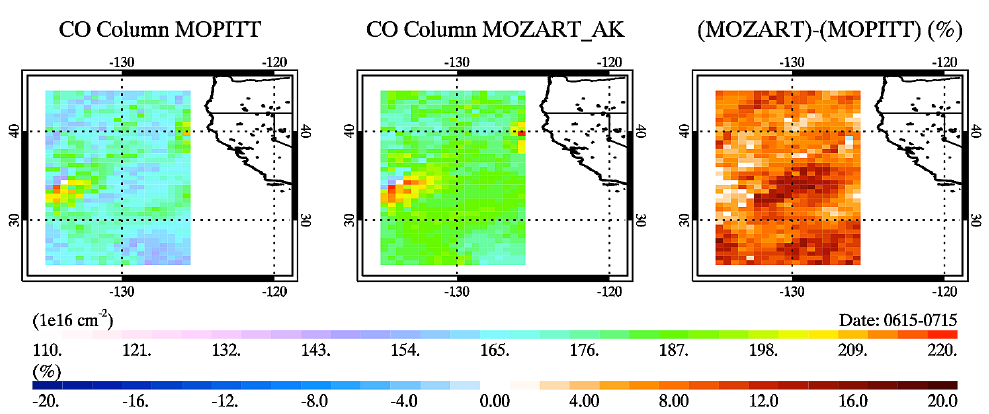
Fig. 4. CO Column retrieved from MOPITT for 15 June–15 July, 2008 and corresponding MOZART-4 simulations with MOPITT operator applied for an oceanic region west of the WRF-Chem domain. A difference plot shows the percentage difference between MOZART-4 and